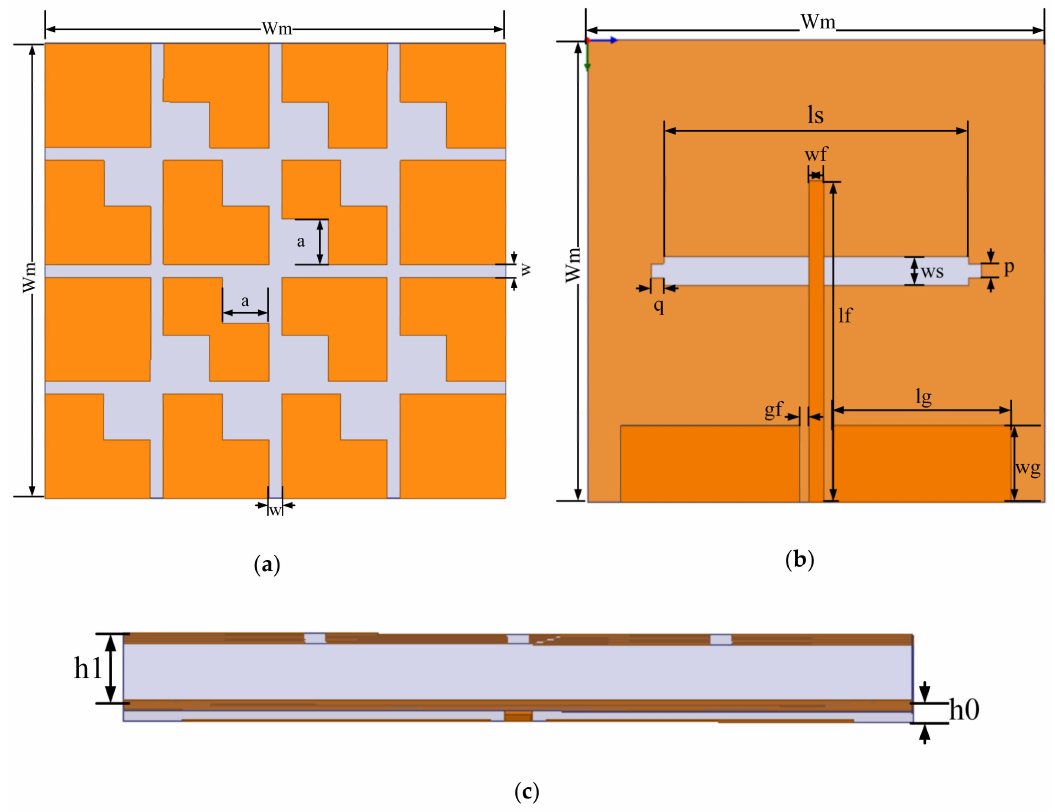
Figure 1. Geometry of the proposed antenna: ( a ) top view; ( b ) rear view; ( c ) side view. Table 1. Design parameters of the proposed circularly polarized metasurface antenna (in